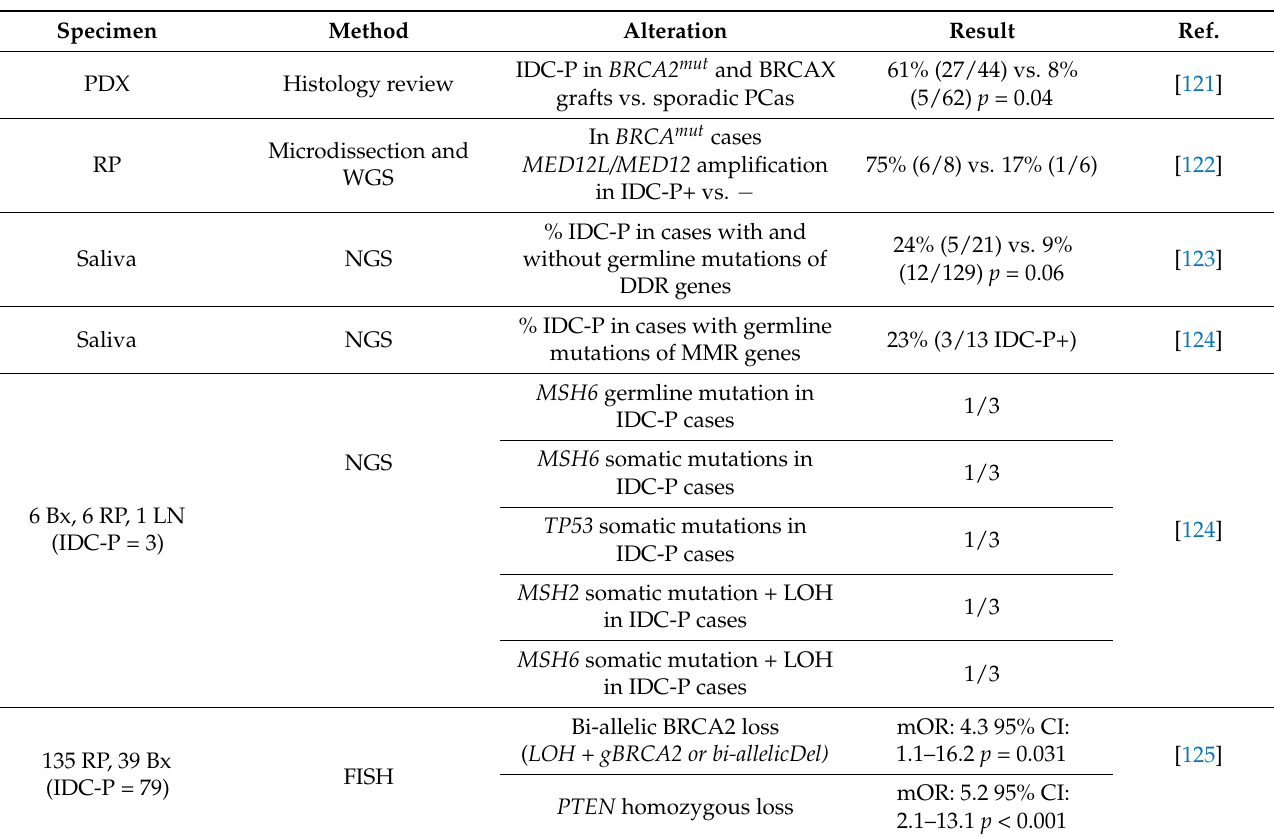
Table 4. Overview of the studies associating IDC-P to deleterious germline and somatic alterations of DNA-damage repair